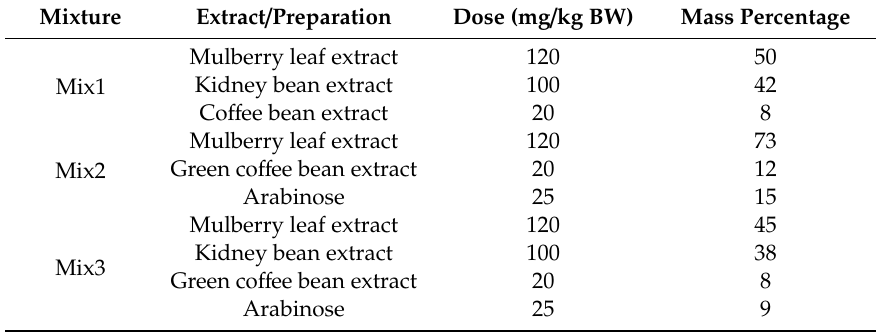
Table 5. Recipes of mixtures administered to rats via gavage.